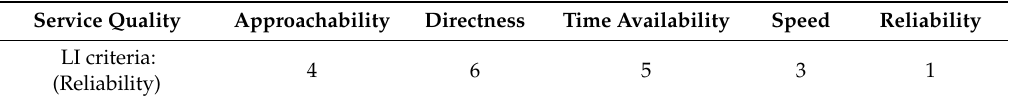
Table 6. Example of evaluating service quality criteria by comparing to the least important one. Service Quality Approachability Directness Time Availability Speed